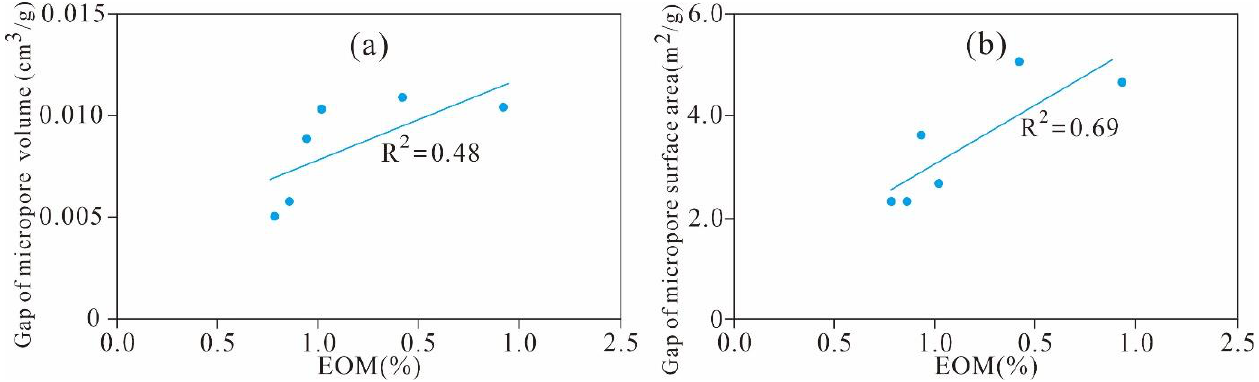
Figure 22. Relationships between the EOM and gap value of the ( a ) micropore volume and ( b ) surface area.